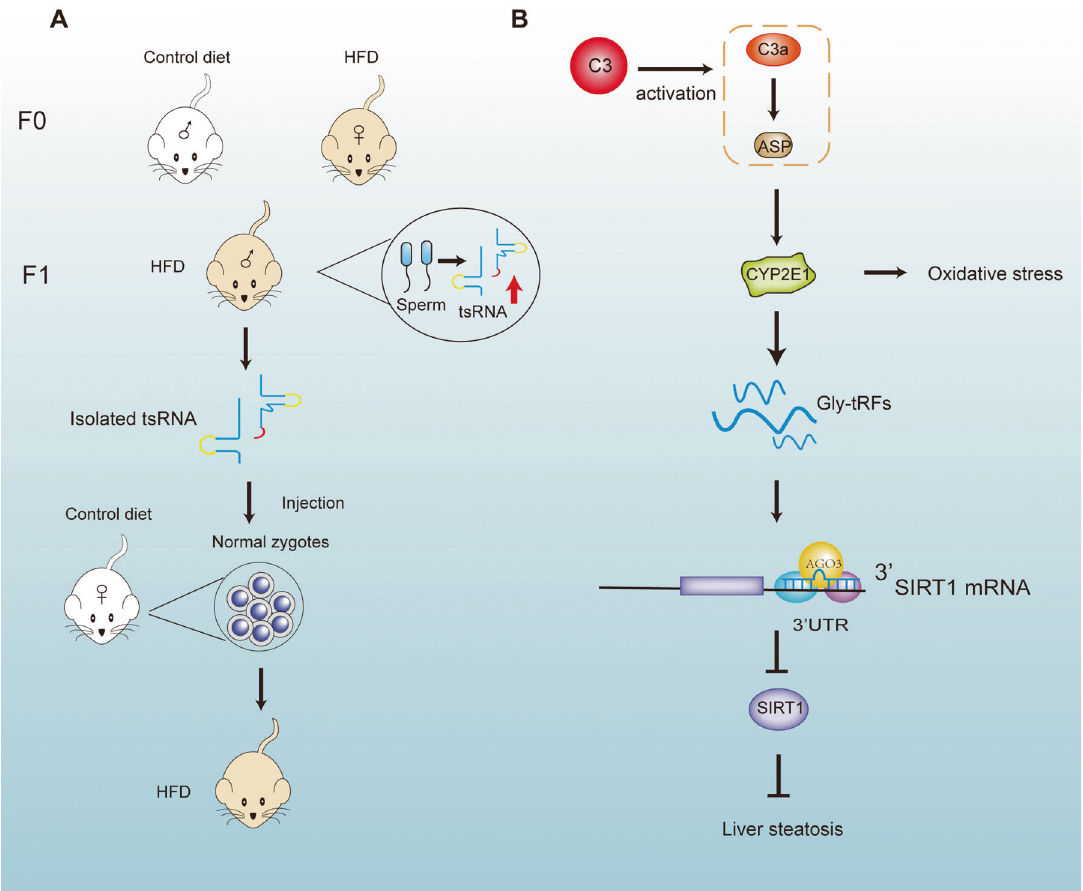
Fig. 5 Representative mechanisms of tsRNAs in metabolic diseases. A Sperm tsRNA contributes to the intergenerational transmission of maternal HFD-induced addictive behaviors and phenotypes. B Complement C3 is involved in alcohol-induced liver damage and steatosis through the induction of